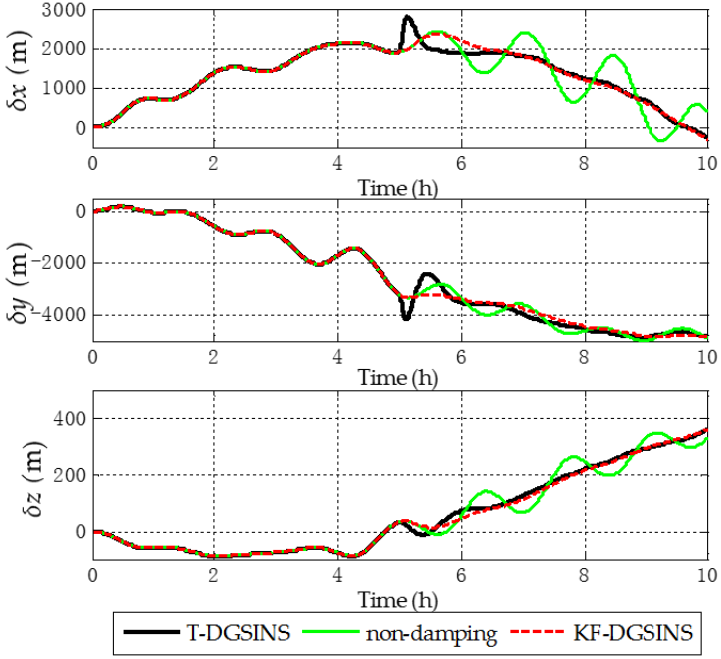
Figure 15. Position errors in e frame of the semi-physical simulation results.